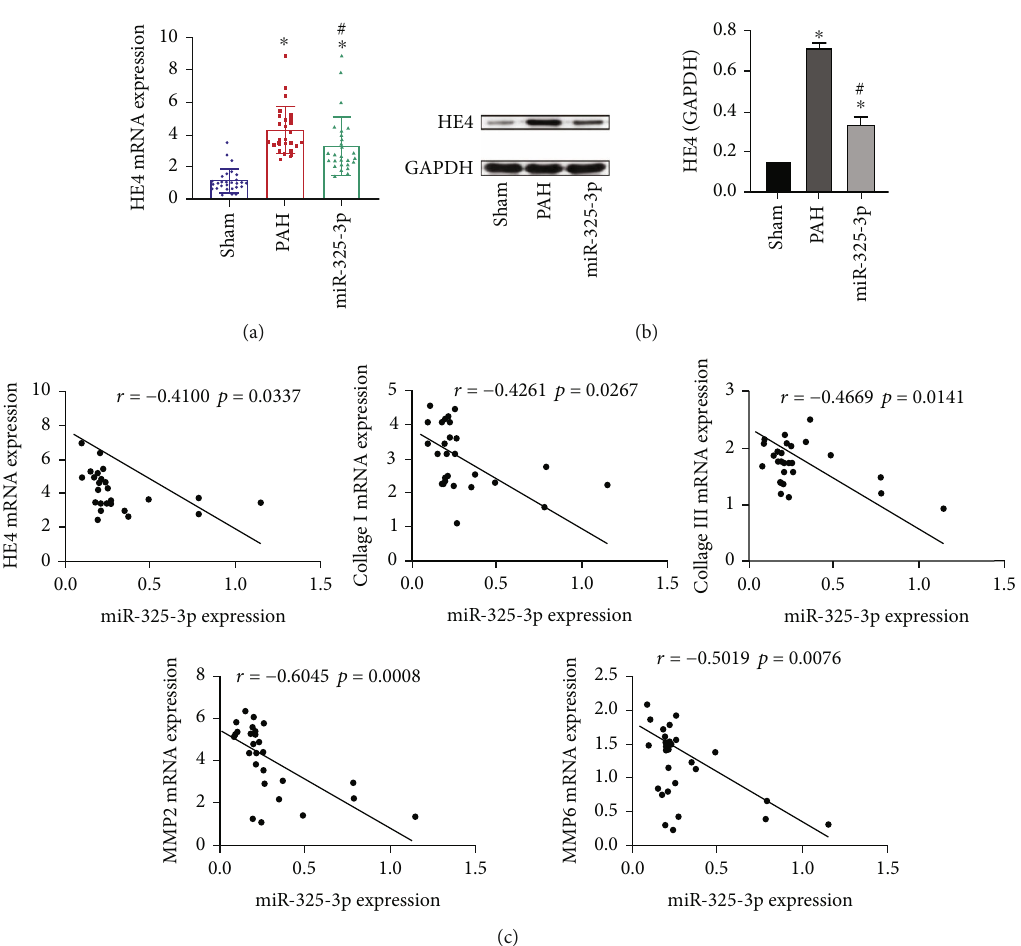
Figure 2: HE4 was negatively correlated with miR-325-3p expression. (a) HE4 expression in right heart tissue was assessed by qRT-PCR. (b) Western blot was used to detect the expression of HE4 in right heart tissue. (c) Pearson correlation coe ffi cient was used to analyze miR-325- 3p and HE4, collagen I, collagen III, MMP2, and MMP9 correlation. ∗ P < 0 : 05 vs. Sham; # P < 0 : 05 vs.